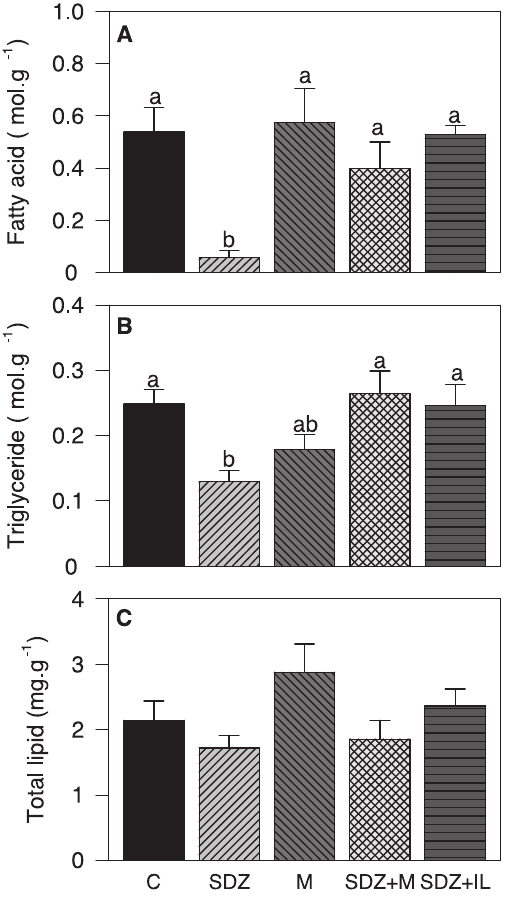
Figure 3. Changes in the levels of metabolites in hypothalamus after intraperitoneal treatment. Levels of fatty acid (A), triglyceride (B), and total lipid (C) in hypothalamus of rainbow trout after 6 h of intraperitoneal administration of 10 mL.Kg 2 1 of saline solution alone (control, C) or containing SDZ WAG 994 (SDZ, 60 m g.Kg 2 1 ), metyrapone (M, 1 mg.Kg 2 1 ), both SDZ WAG 994 and metyrapone (SDZ + M), or both SDZ WAG 994 and intralipid (3 mL.Kg 2 1 ) solution (SDZ + IL). The results are shown as mean + S.E.M. of 10 fish per treatment. Different letters indicate significant differences ( P , 0.05) among treatments.